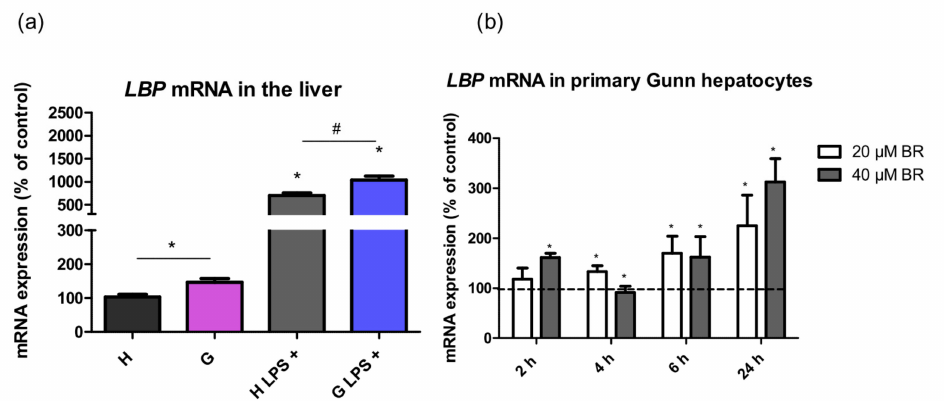
Figure 4. The e ff ects of hyperbilirubinemia on lipopolysaccharide binding protein ( LBP ) mRNA expression in the liver tissues upon exposure to LPS (6 mg / kg i.p.) and in primary hepatocytes. mRNA expression of LBP was measured in the liver tissue ( a ) of normobilirubinemic heterozygous controls (H or H LPS + ) and hyperbilirubinemic Gunn rats (G or G LPS + ), respectively, and in primary hepatocytes ( b ). Primary hepatocytes isolated from Gunn rats were incubated with BR (20 and 40 µ M) for 2, 4, 6, and 24 h. ( b ) Values are expressed as % of untreated control cells (100%). * p < 0.05 vs. controls, # p < 0.05 vs. LPS-treated group. ( a ) n = 12 animals per group (minimum); ( b ) n = 6 independent cell cultures per